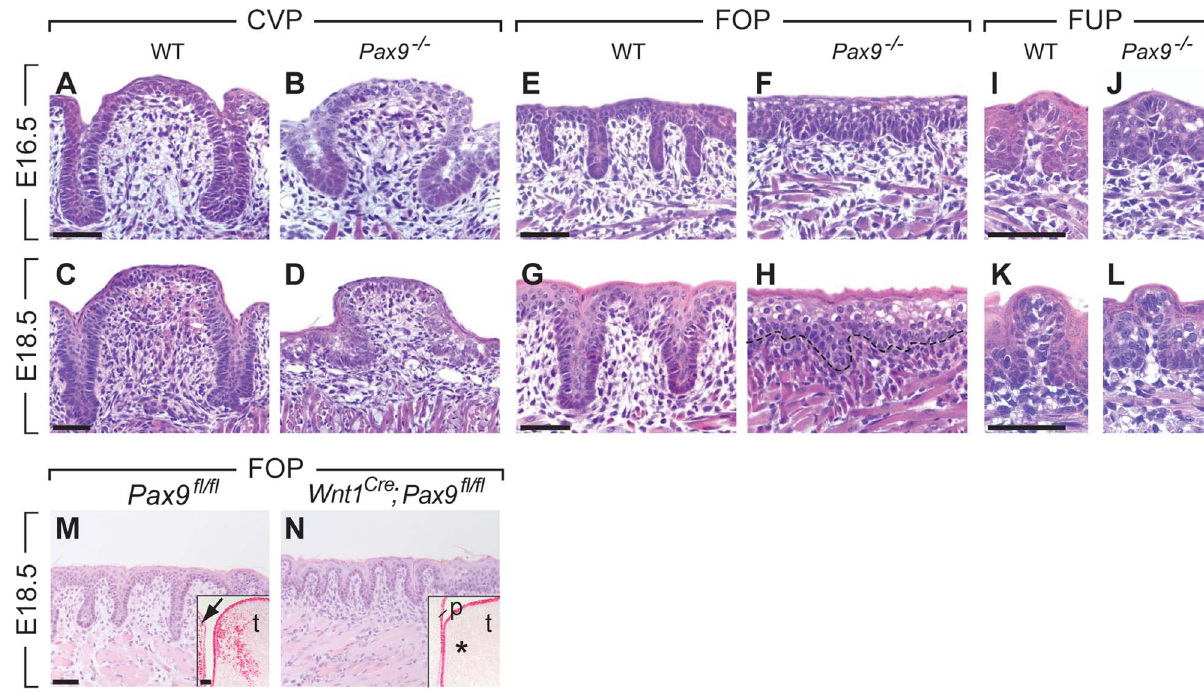
Figure 2. Arrest of CVP and FOP development in Pax9 -deficient mouse embryos. ( A,C ) In wild type (WT) embryos, the invaginating CVP epithelium forms deep trenches. ( B,D ) Rudimentary CVP trenches form in Pax9 2 / 2 embryos at E16.5 (B) but these trenches fail to invaginate (D). ( E,G ) A series of invaginations develop in the FOP of wild type embryos. ( F,H ) FOP trenches are absent in Pax9 mutants. ( I–L ) FUP development on the dorsal tongue. The FUP of wild type embryos (I,K) and Pax9 2 / 2 embryos (J,L) are morphologically indistinguishable. ( M,N ) FOP development in Pax9 fl/ fl embryos. (M) Without Cre expression, FOP development at E14.5 is normal and Pax9 expression is detectable in both epithelium and mesenchyme of the tongue (t), as well as in the adjacent lower jaw mesenchyme (arrow; inset shows a coronal section of the posterior region of the tongue). (N) Wnt1 Cre -mediated inactivation of Pax9 fl/fl did not disrupt the formation of epithelial invaginations. Note that Pax9-positive cells are not detectable in the tongue mesenchyme (asterisk in inset) or in the mesenchyme of the non-elevated secondary palate (p). Scale bars: 50 m m.